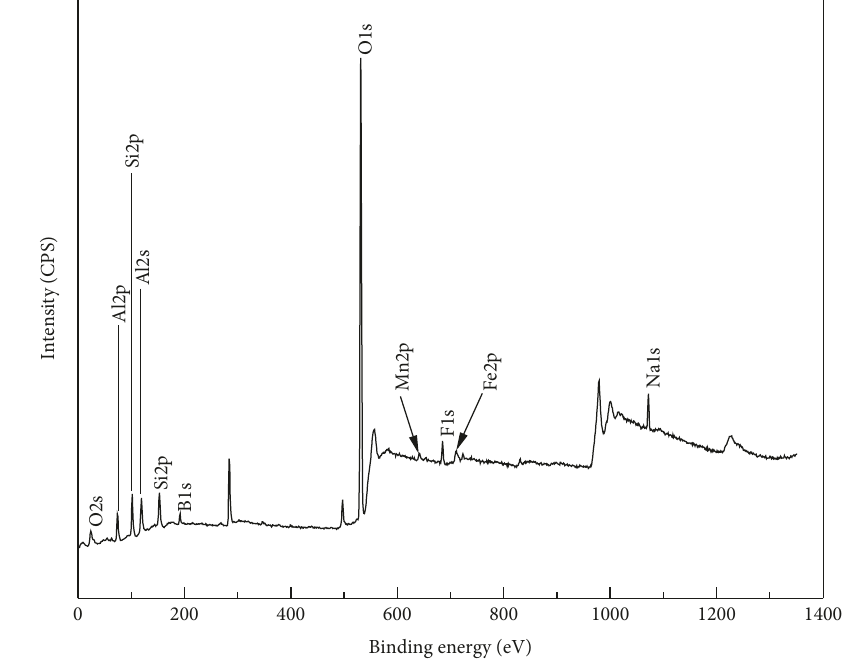
Figure 5: XPS spectrum of the tourmaline sample.